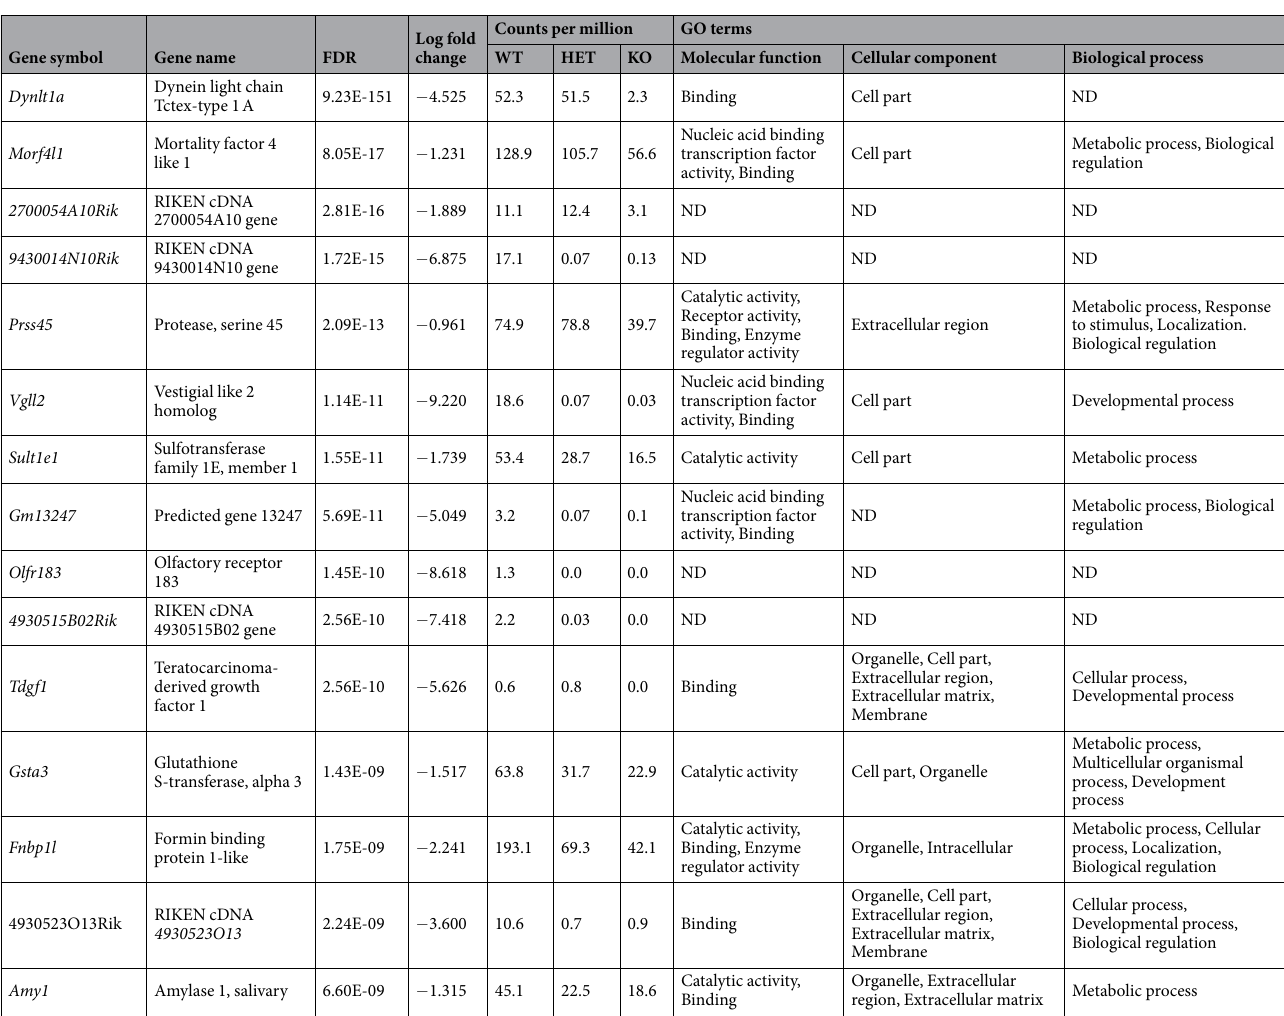
Table 2. Top-15 downregulated genes in the testes of PLAG1 - deficient mice. FDR, false-discovery rate; GO, gene ontology; HET, heterozygote; KO, knock-out; ND, not determined; WT,